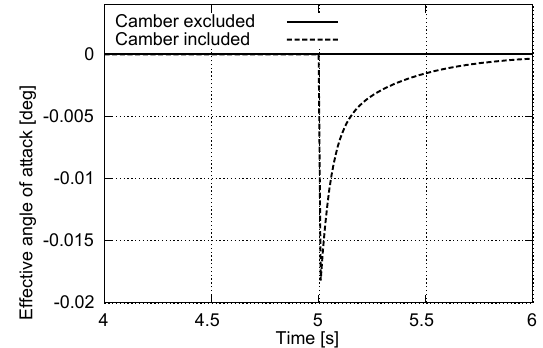
Figure 4. Effect of including camber in the unsteady aerodynamics model on effective angle of attack during a step in relative velocity.